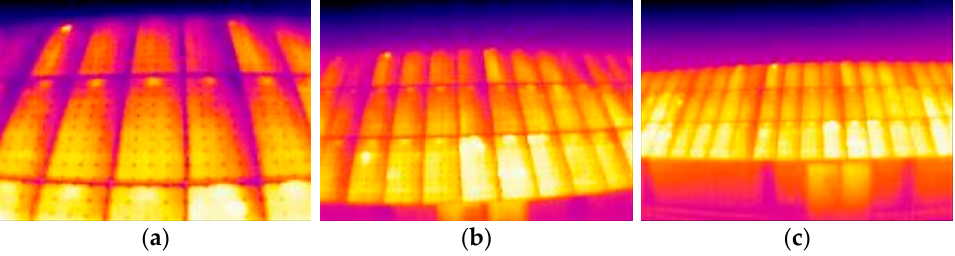
Figure 21. Comparison to show the uniformity of the thermal reading at the limiting and calculated distances. ( a ) 3 m away; ( b ) 5 m away; and ( c ) 7 m away. distances. ( a ) 3 m away; ( b ) 5 m away; and ( c ) 7 m